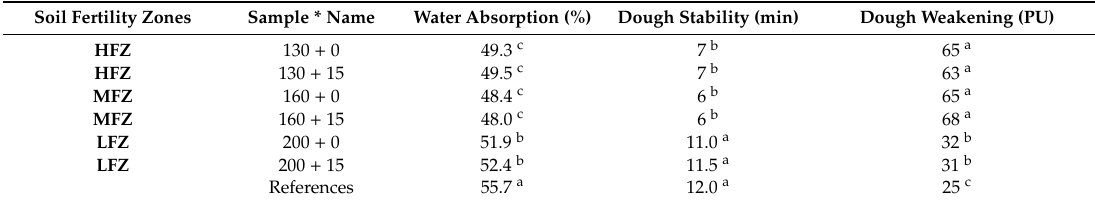
Table 2. Mixing properties ( n = 3) of dough samples obtained from site-specific harvest of cv. Biensur compared with those of the commercial reference cv. Aureo